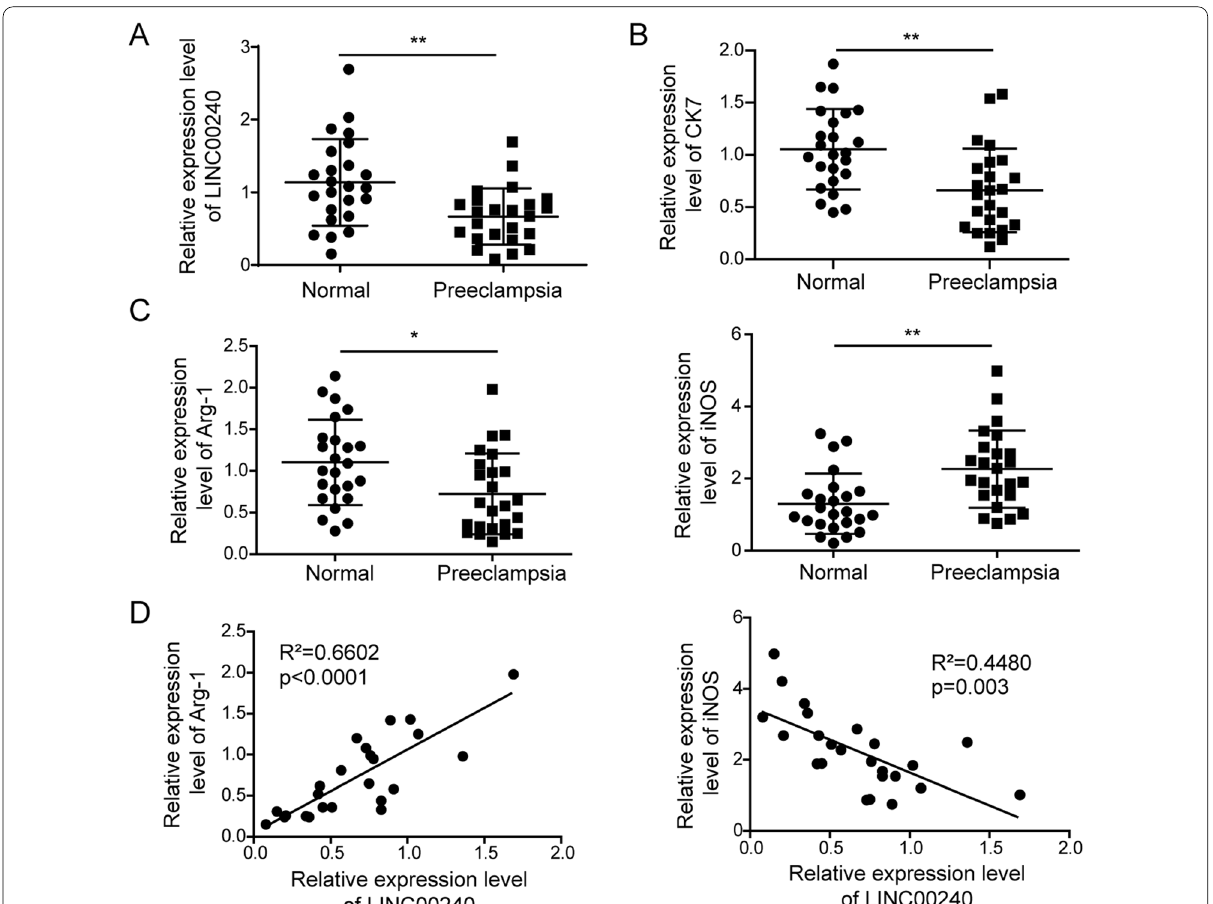
Fig. 1 LINC00240 is downregulated in placenta samples of preeclampsia patients. A qPCR measurement on LINC00240 levels in placenta tissues from preeclampsia patients (n 24) and normal pregnant women (n 24). B qPCR measurement on CK7 levels in placenta tissues from = = preeclampsia patients (n 24) and normal pregnant women (n 24). C qPCR measurement on Arg‑1 and iNOS levels in placenta tissues from = = preeclampsia patients (n 24) and normal pregnant women (n 24). D A correlation analysis between Arg‑1, iNOS, and LINC00240 levels in = = placenta tissues from preeclampsia patients (n 24). * P < 0.05 and ** P < 0.01 =